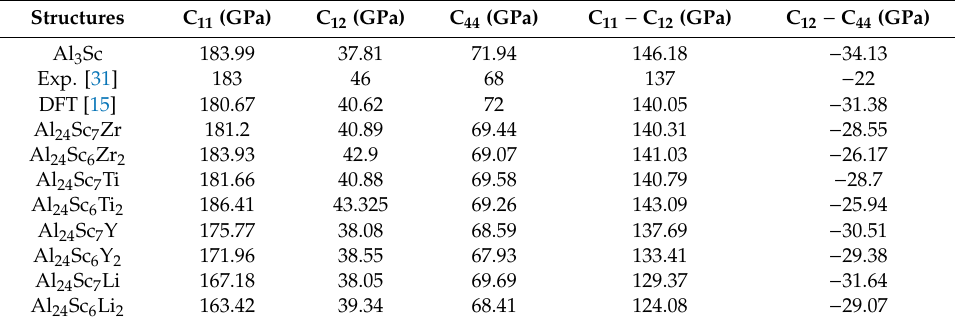
Table 2. Calculated elastic constants Cij for L1 2 -Al 3 Sc 1– x M x at the ground state.